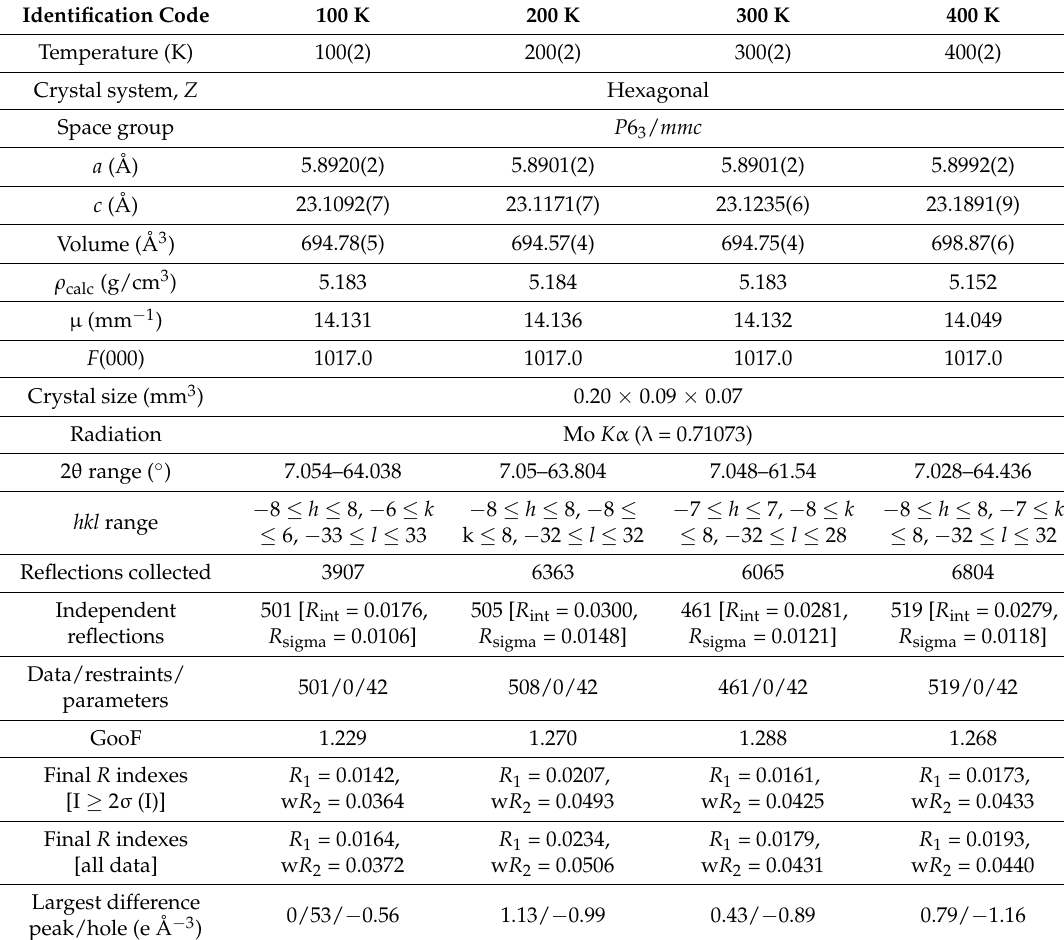
Table 1. Crystal data and structure refinement for barioferrite at 100, 200, 300, and 400